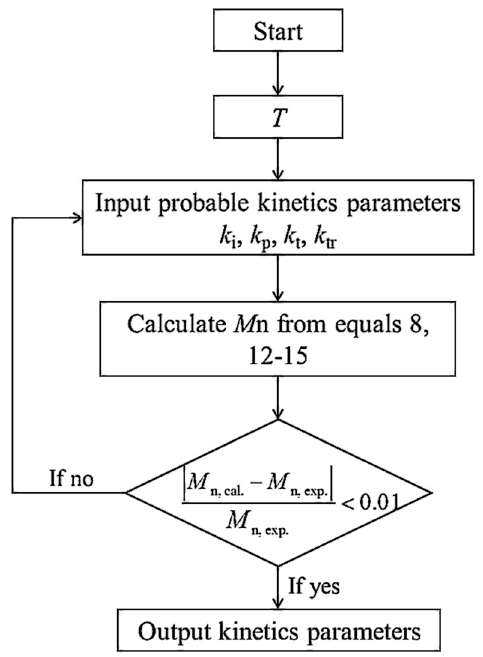
Figure 5. These kinetic parameters estimated from experimental data and modeling results